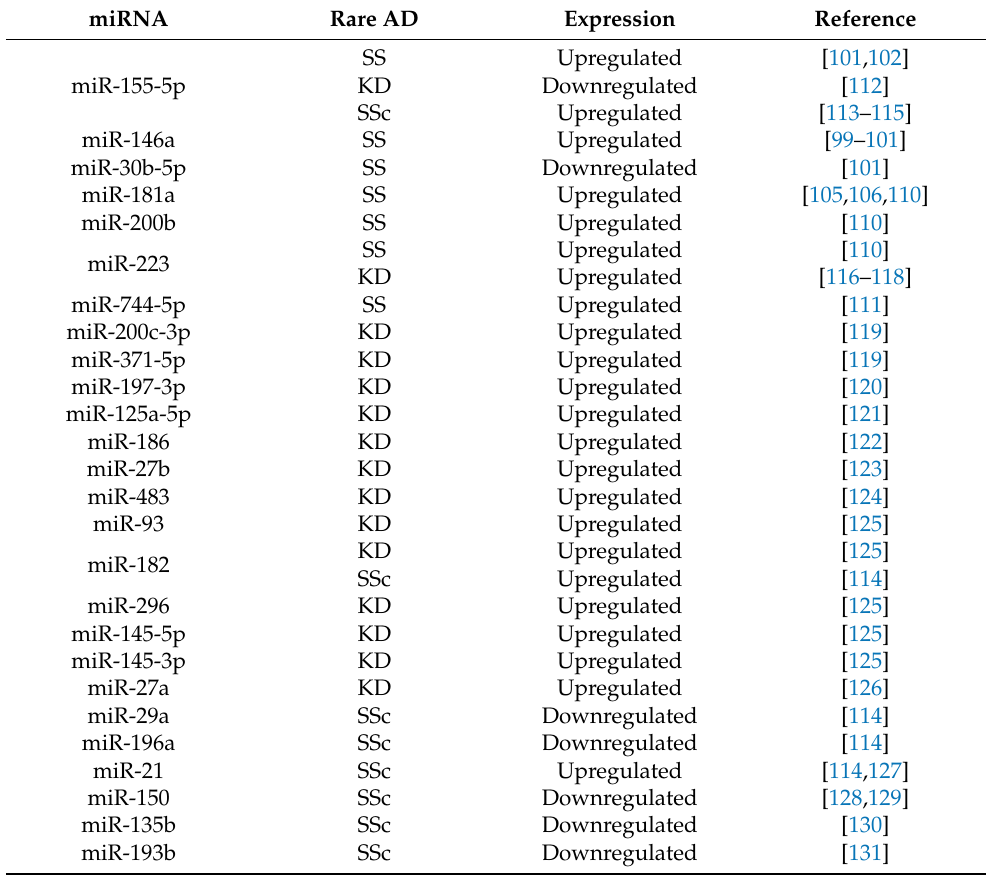
Table 1. miRNAs in rare autoimmune